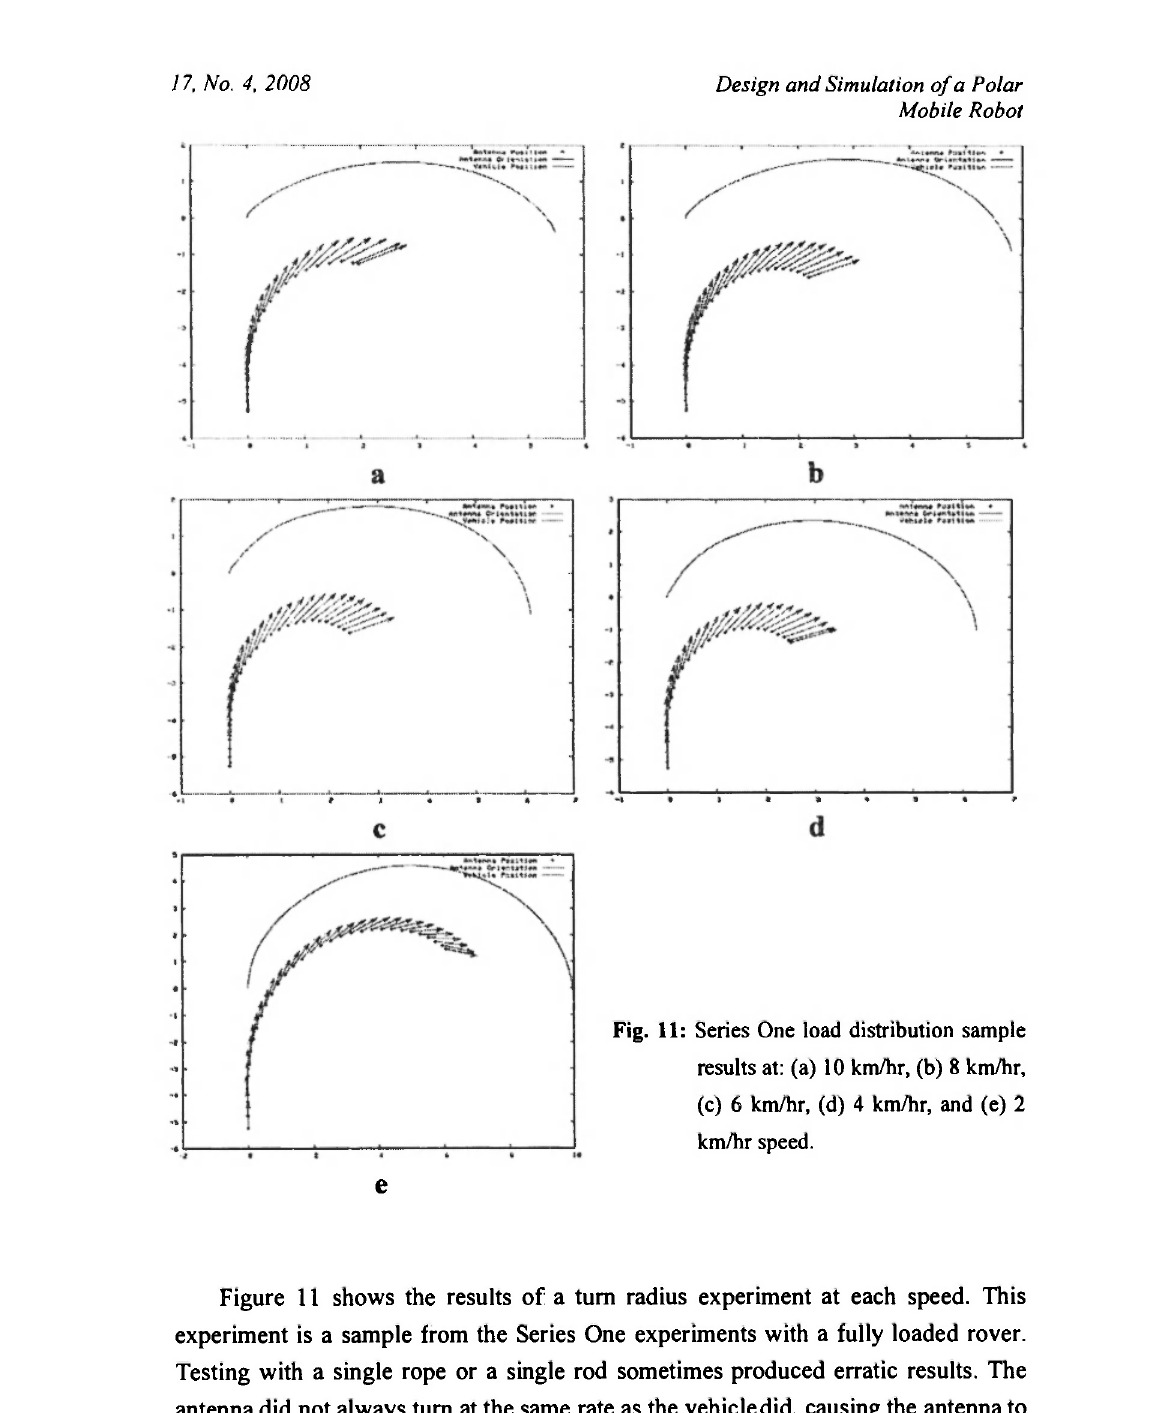
Fig. 11: Series One load distribution sample results at: (a) 10 km/hr, (b) 8 km/hr, (c) 6 km/hr, (d) 4 km/hr, and (e) 2 km/hr e